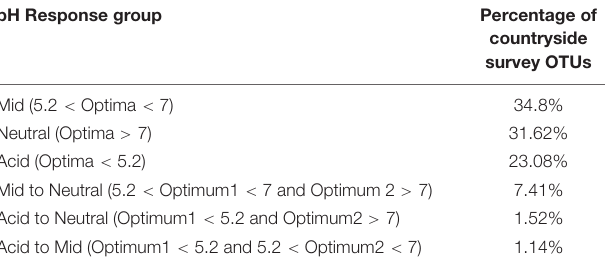
TABLE 3 | Percentage of 13,781 CS OTUs classified to different pH response groups.